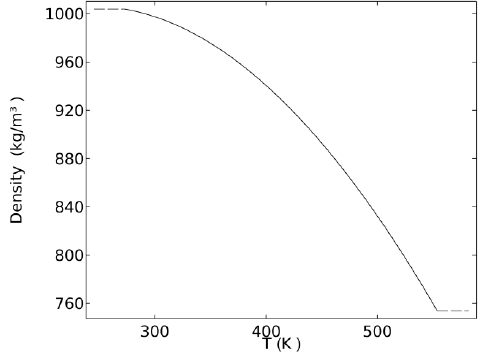
Figure 8. The density of the water changes with temperature.